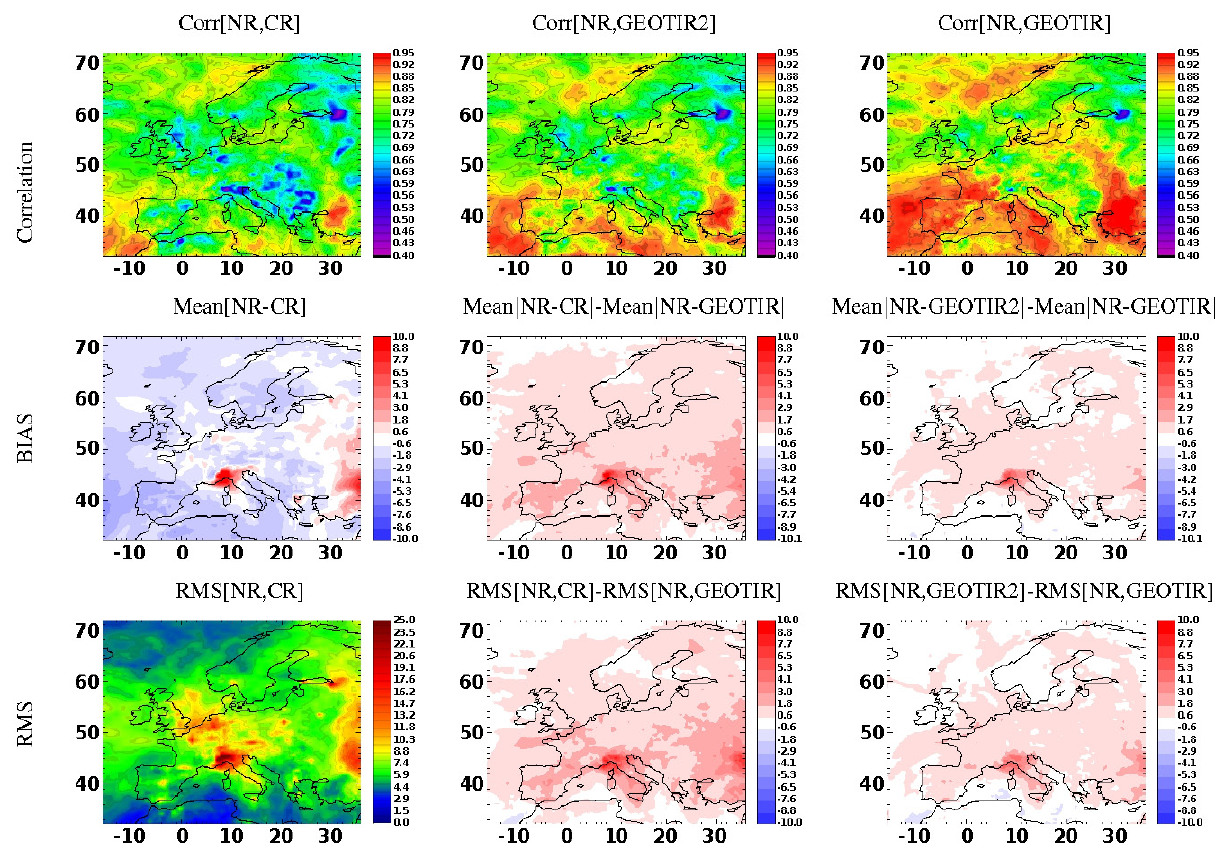
Fig. 6. Same as Fig. 5 (EXP1) but for